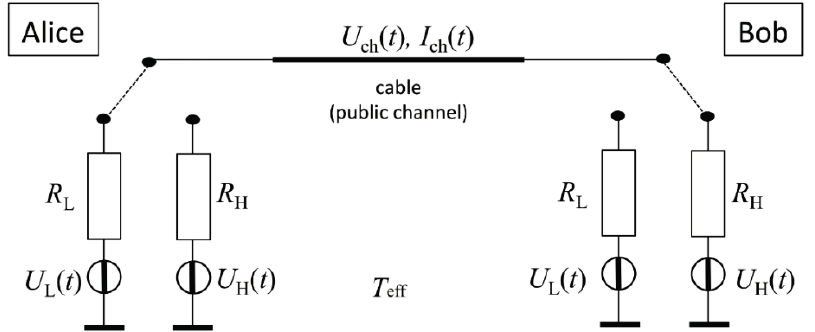
Figure 1. The core of the KLJN secure key exchange system [2]. The resistor values are U t and   R and R . The thermal noise voltages,   U t , are generated at an effective L L H H T (typically T  10 14 K ) [40]. The channel noise voltage and current are temperature eff eff   U t and   I t , ch ch